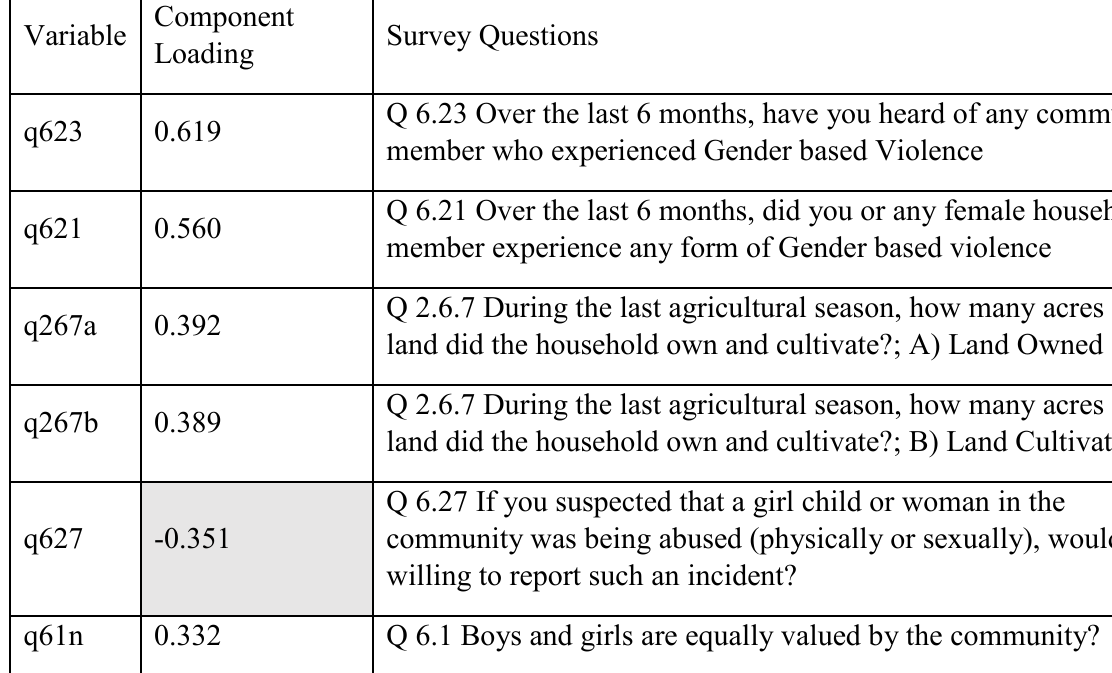
Table 1.46: Variables defining Transformative Resilience PC4